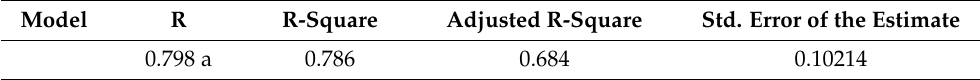
Table 7. Model Summary.